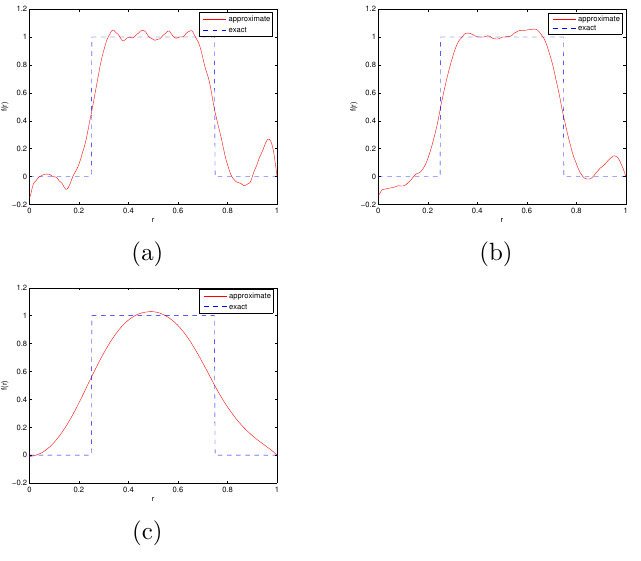
Figure 4 (a), (b) and (c) show the results with different fractional orders α with a fixed noise level δ = 1% , ˜ α = 1 ∗ 10 − 6 . The larger α is, the worse reconstruction result is. This is because the degree of ill-posedness increases as the fractional order α increases. And the degree of ill-posedness becomes the